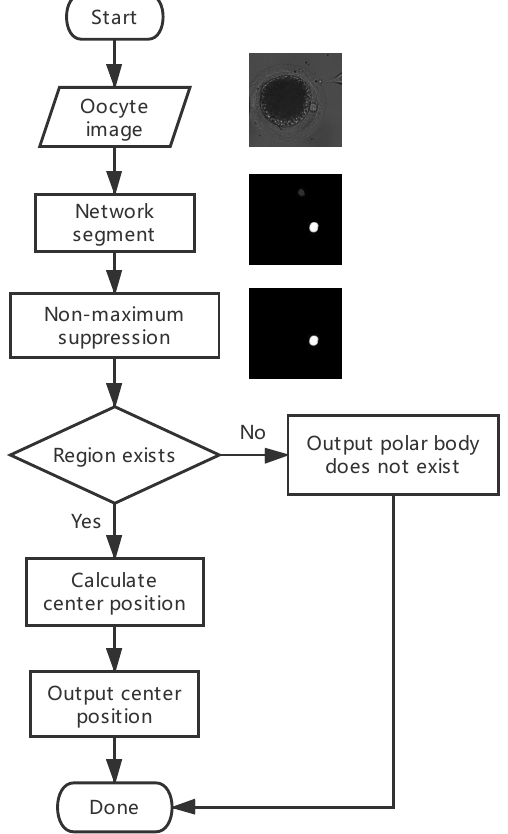
Figure 5. Flowchart of polar-body detection